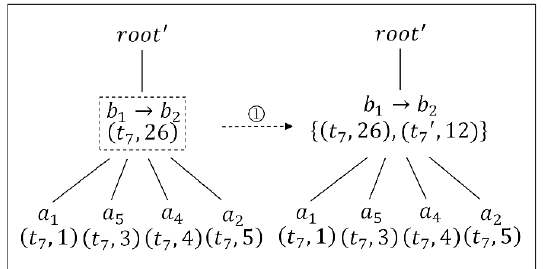
Figure 6. Updating of the TP-tree by using a dummy trajectory. The number ① represents a dummy trajectory 𝑡 (cid:2875)(cid:4593) = 𝑏 (cid:2869) → 𝑏 (cid:2870) is added.